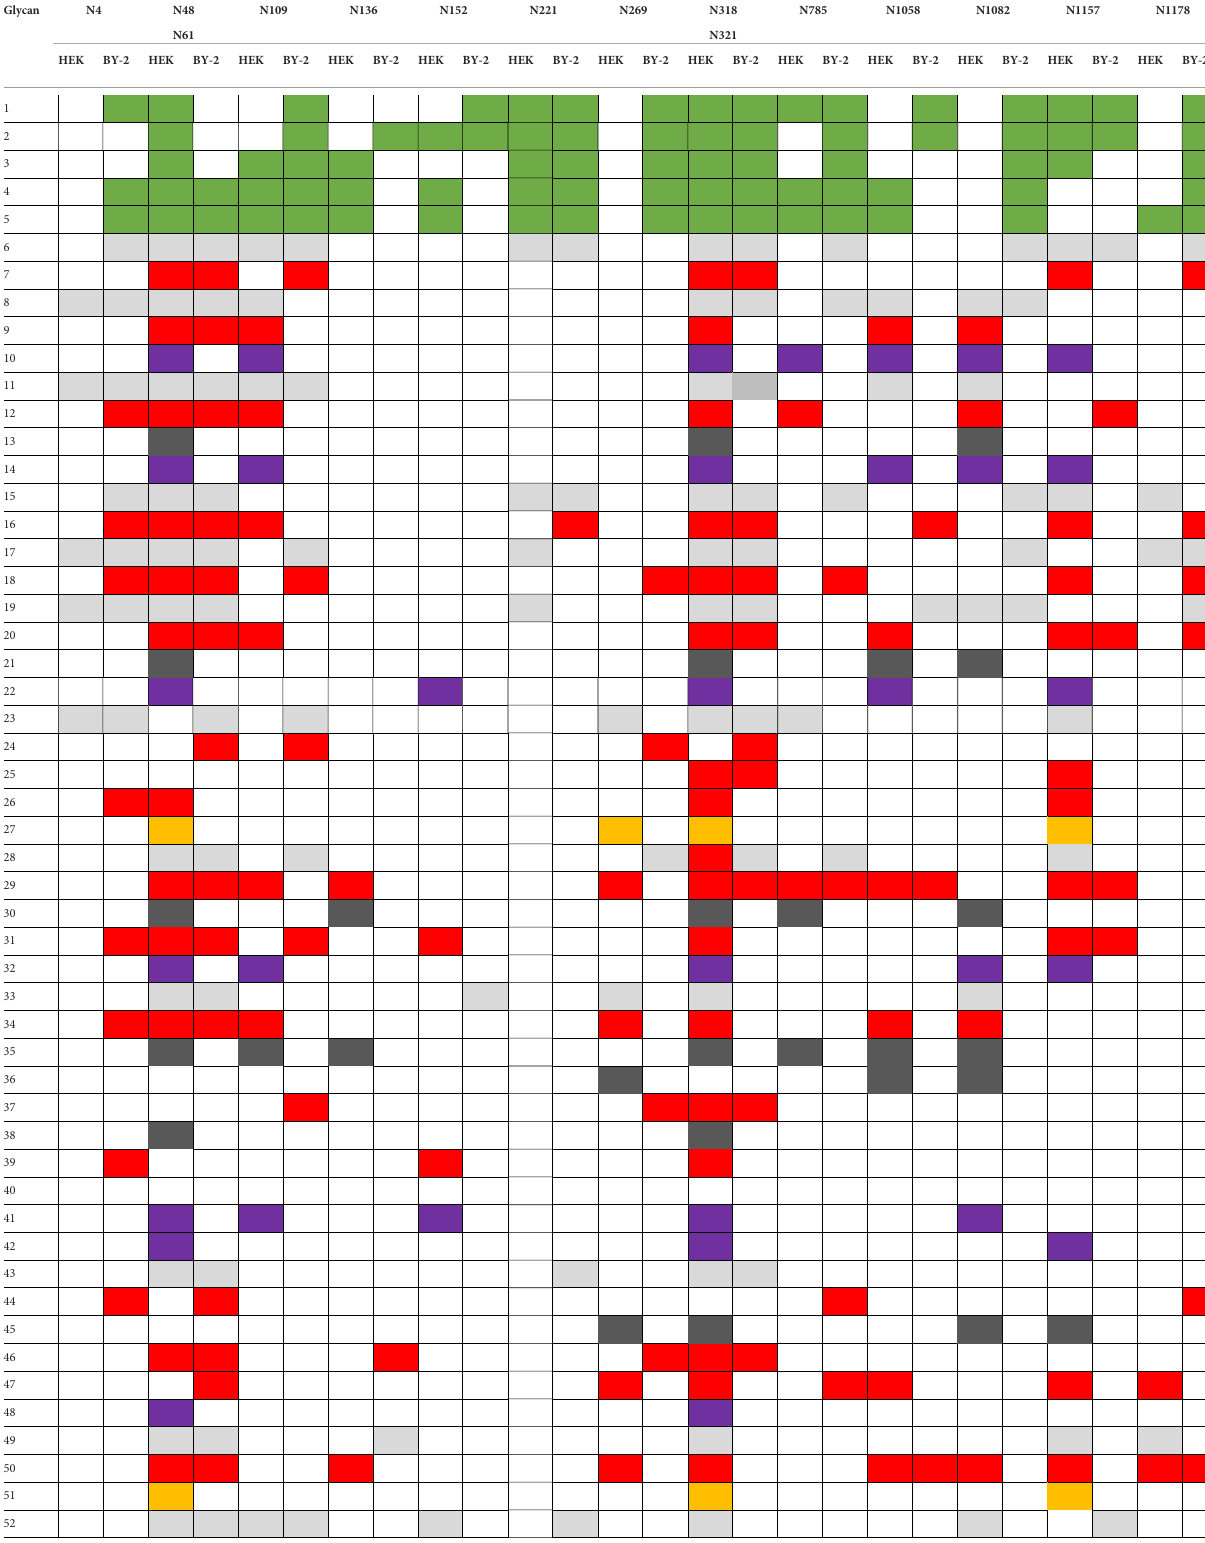
TABLE 2 Comparison of glycan composition between the recombinant Spike produced in BY-2 cells and the Spike produced in human HEK293- E6 cells (Castro et al., 2021). Glycan N4 N48